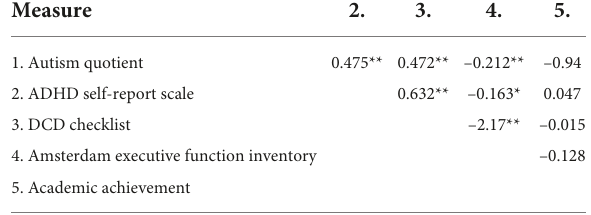
TABLE 2 Correlation matrix of